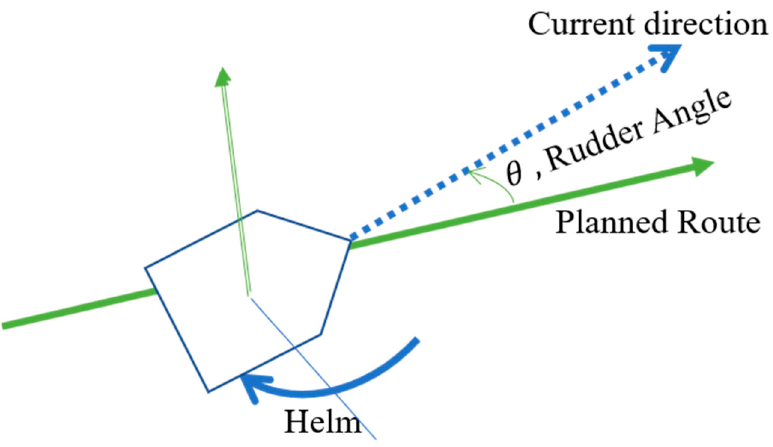
Figure 2. Relation between helm and rudder angle.